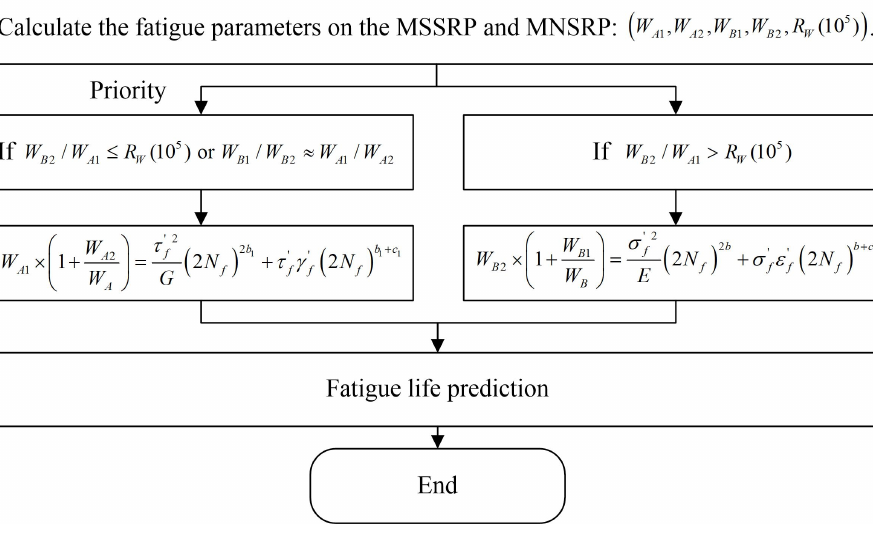
Figure 2. The procedures to employ the proposed